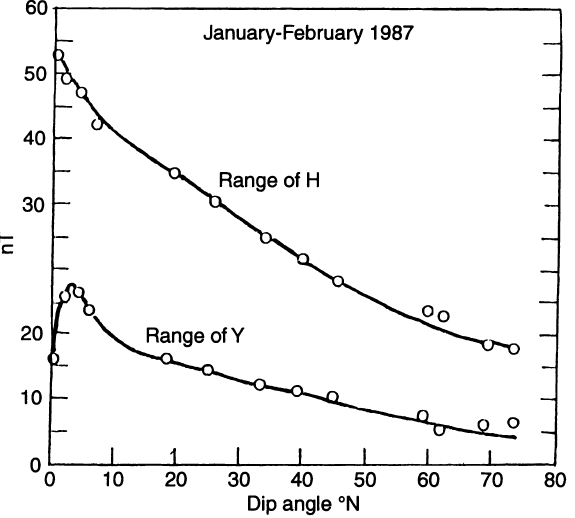
Fig. 3. The latitudinal variations of the ranges of H and Y fields during January–February, 1987